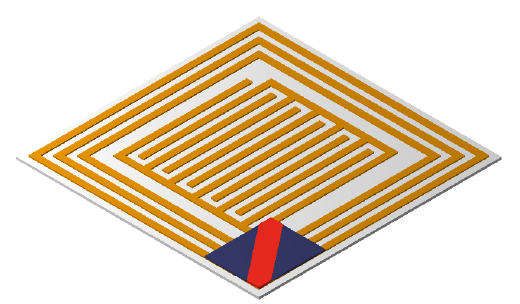
Figure 1. The LC sensor is comprised of a serial connected LC circuit printed on a paper